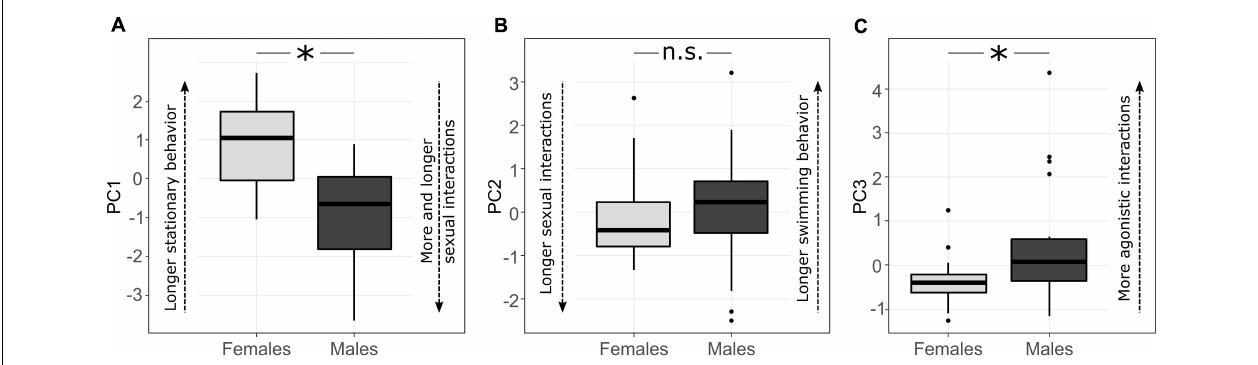
FIGURE 2 | The boxplots represent the differences between sexes in: (A) PC1 (43% of variance explained); females spent more time in stationary position and experienced less and shorter sexual interactions compared to males. (B) PC2 (27% of variance explained); males and females did not differ in how much time they were observed swimming or experiencing sexual interactions. (C) PC3 (20% of variance explained); Males performed more aggressive behaviors than females. ∗ Significant effect of sex in all the LMMs, n.s.: non-significant effect of sex in all the LMMs (see Table 3